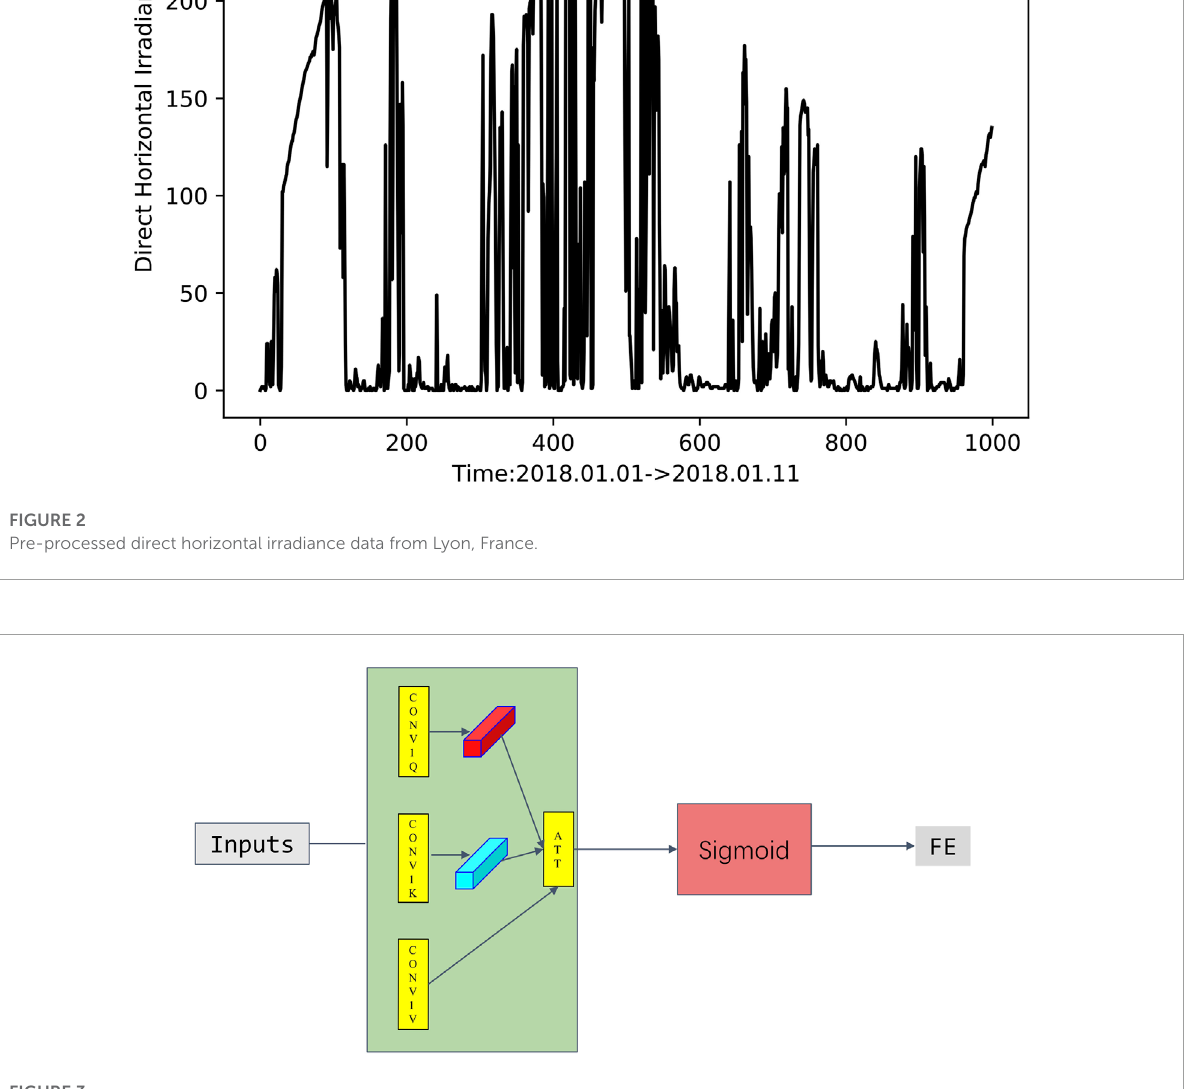
FIGURE 3 Feature-enhanced